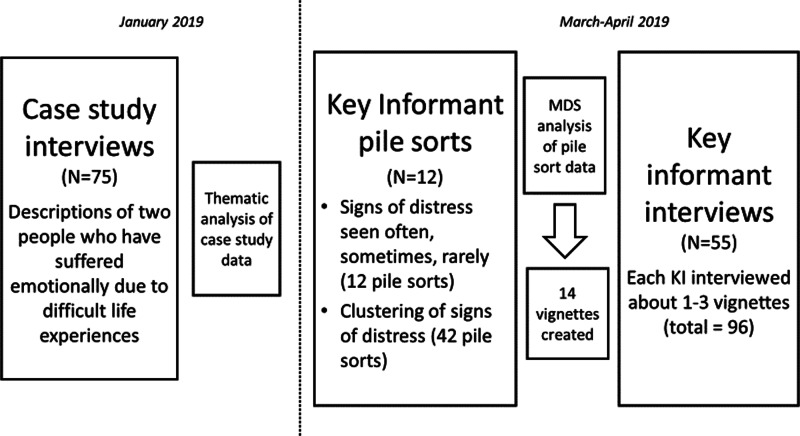
Design of study.